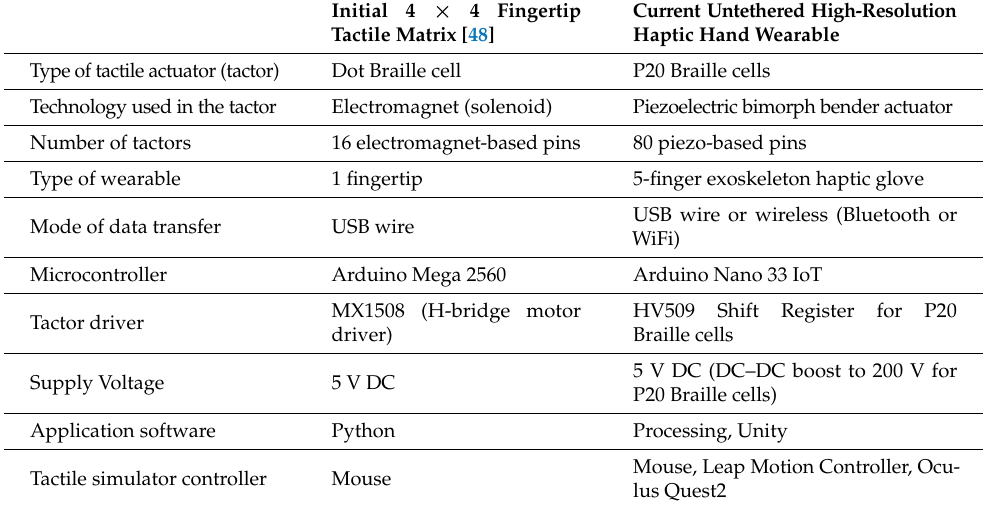
Table 1. Comparison of our “4 × 4 Fingertip Tactile Matrix” and “Untethered High-Resolution Haptic Hand